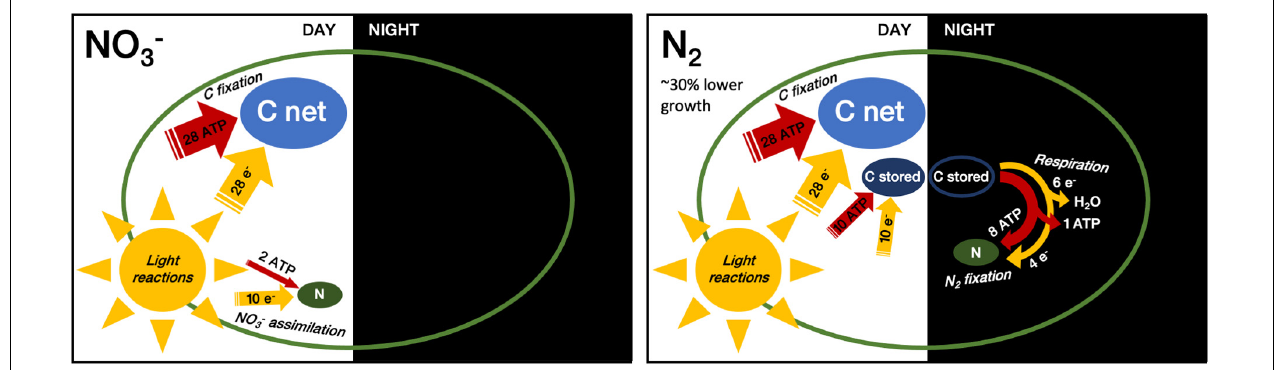
FIGURE 8 | Relative consumption of energy equivalents by C and N assimilation in NO 3 − consuming vs. N 2 fixing cells. Width of arrows and size of pools reflect approximate relative amounts of energy equivalents (ATP and reducing equivalents) and pool sizes (C net, C stored and N) per mole of assimilated N. This figure compares direct assimilation costs for C and N, ignoring basal respiration as well as indirect costs such as those for daily de novo synthesis of nitrogenase. While carbohydrate accumulation occurs in both N conditions, N 2 -fixation requires the build-up of an additional, transient C pool (C stored) that is respired to fuel N 2 -fixation during the following